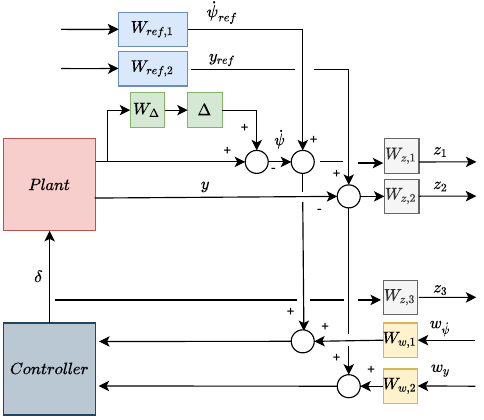
Figure 9. Augmented system for control design.